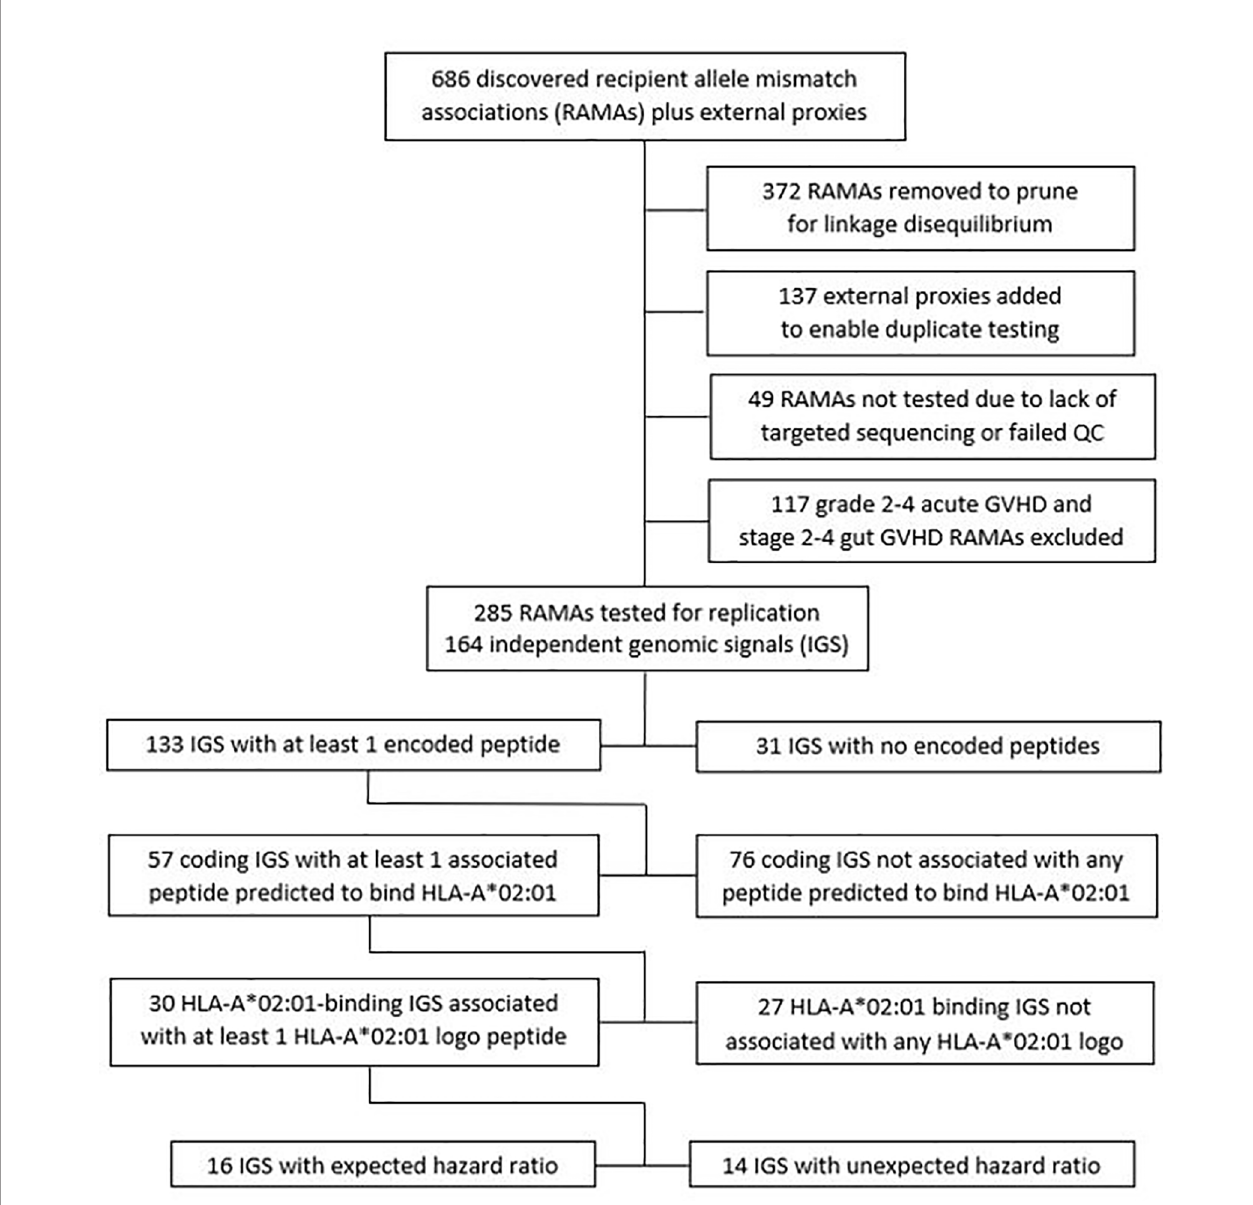
FIGURE 4 | Replication testing of recipient allele mismatch associations (RAMAs) identi fi ed in the discovery cohort. Testing in the replication cohort was limited to no more than 2 members of each linkage group constituting an independent genomic signal (IGS). Discovery hazard ratios >1.0 for acute and chronic GVHD and <1.0 for relapse were categorized as expected, while discovery hazard ratios <1.0 for acute and chronic GVHD and >1.0 for relapse were categorized as unexpected. Each linkage group was characterized according to whether any variant in the group codes a source protein, is predicted to produce a processed peptide that binds to HLA-A*02:01 or to generate a peptide with an HLA-A*02:01 sequence